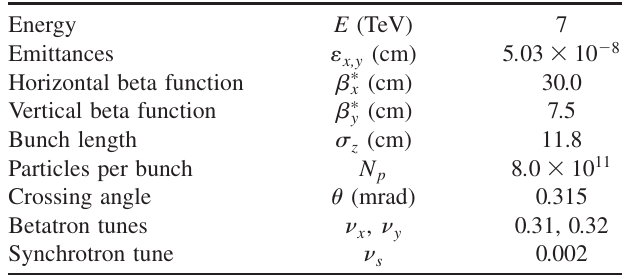
FIG. 10. Beam-beam resonances versus the crab value for SuperB LER. TABLE III. LHC parameters used in crab waist